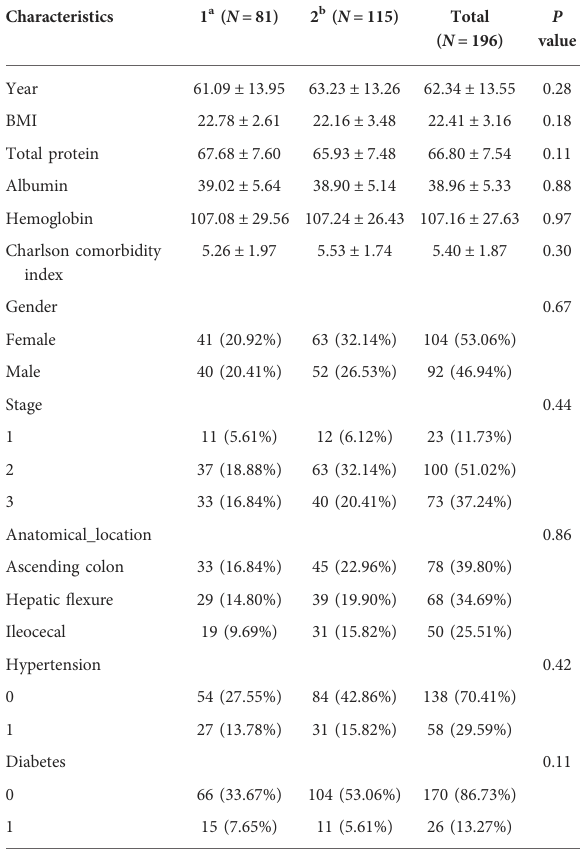
Table 1 Comparison of preoperative baseline data between the two groups of patients ( n =196).